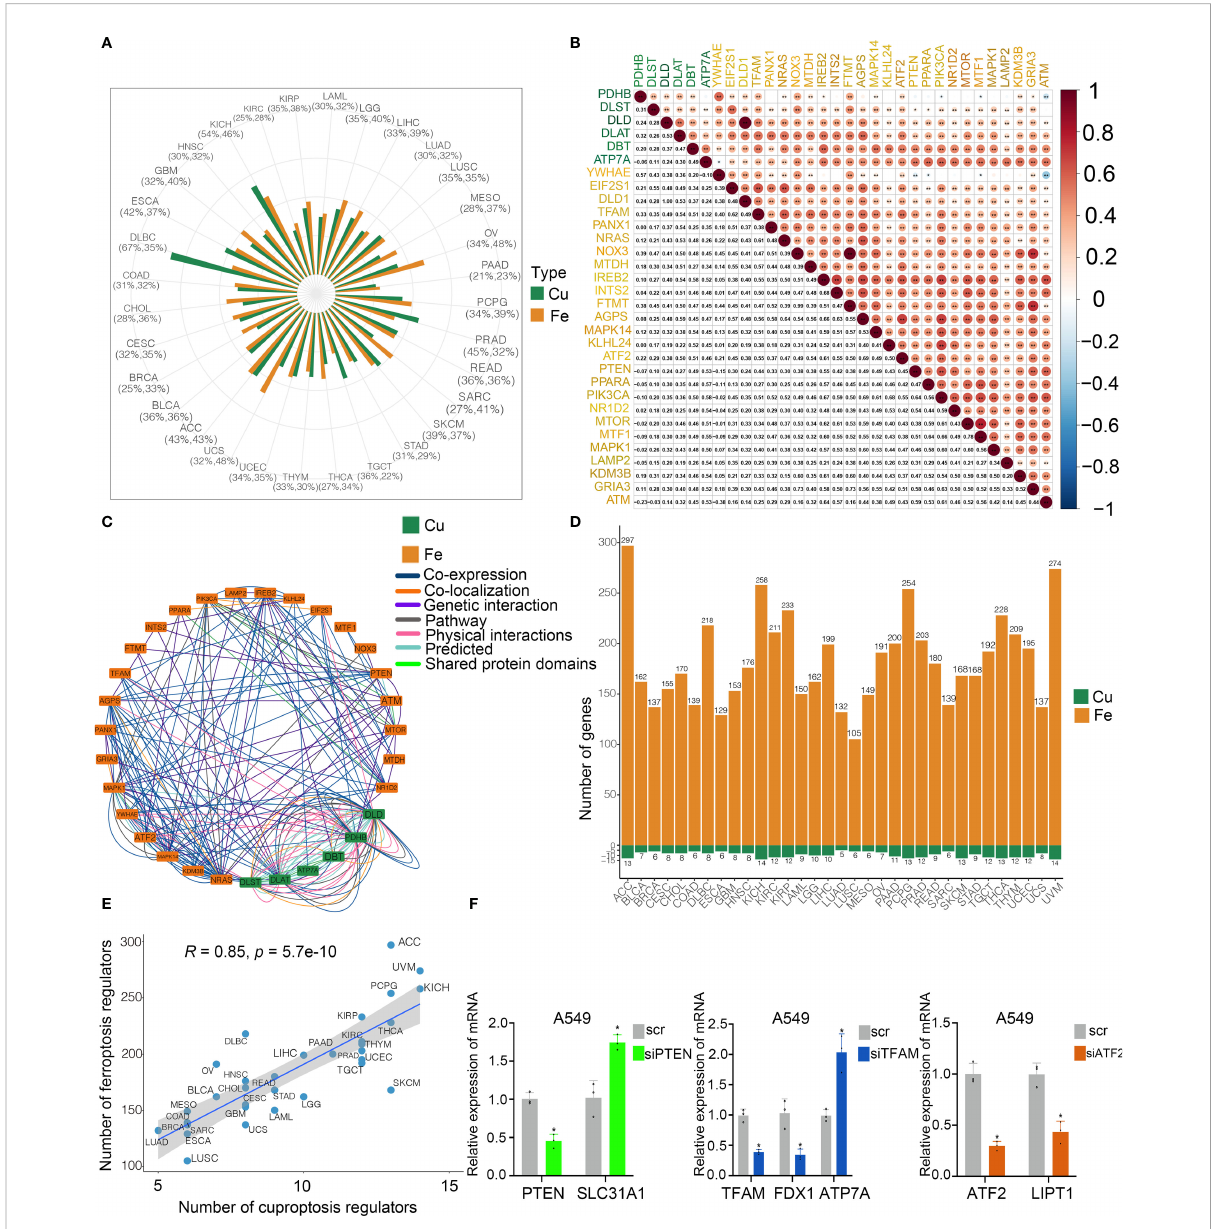
FIGURE 3 Cross-talk identi fi ed among cuproptosis and ferroptosis regulators in cancers. (A) Mutation frequency of cuproptosis and ferroptosis regulators in 33 cancer types. Green bar, mutation of cuproptosis regulators; Orange bar, mutation of ferroptosis regulators. (B) Co-occurrence of genetic alterations in the cuproptosis and ferroptosis regulators. Cuproptosis regulators are presented in green and ferroptosis regulators are in orange. (C) Protein-protein interactions among cuproptosis and ferroptosis regulators based on the GeneMANIA database. (D) Module membership- based hub cuproptosis and ferroptosis regulators across 33 cancer types. The lower panel shows the number of hub cuproptosis and ferroptosis regulators in each cancer type. (E) Correlations between the number of hub cuproptosis regulators and the number of hub ferroptosis regulators. The Pearson correlation coef fi cients (R) were analyzed for the correlation. (F) Levels of cuproptosis regulators after knockdown of ferroptosis regulators in A549 cells by RT-PCR. COAD, colon adenocarcinoma; DLBC, diffuse large B cell lymphoma; ESCA, esophageal carcinoma; GBM, glioblastoma; HNSC, head and neck squamous cell cancer; KICH, kidney chromophobe; KIRC, kidney renal clear carcinoma; KIRP, kidney renal papillary carcinoma; LAML, acute myeloid leukemia; LGG, low grade gliomas; LIHC, liver hepatocellular carcinoma; LUAD, lung adenocarcinoma; LUSC, lung squamous cell carcinoma; MESO, mesothelioma; OV, ovarian cancer; PAAD, pancreatic adenocarcinoma; PCPG, pheochromocytoma and paraganglioma; PRAD, prostate adenocarcinoma; READ, rectum adenocarcinoma; SARC, sarcoma; SKCM, skin cutaneous melanoma; STAD, stomach adenocarcinoma; TGCT, tenosynovial giant cell tumor; THCA, thyroid carcinoma; THYM, thymoma; UCEC, uterine corpus endometrial carcinoma; UCS, uterine carcinosarcoma; ACC, adenoid cystic carcinoma; BLCA, bladder carcinoma; BRCA, breast cancer; CESC, cervical squamous cell carcinoma and endocervical adenocarcinoma; CHOL; cholangiocarcinoma; UVM, uveal melanoma. * p < 0.05, ** p < 0.01, ns, not signi fi